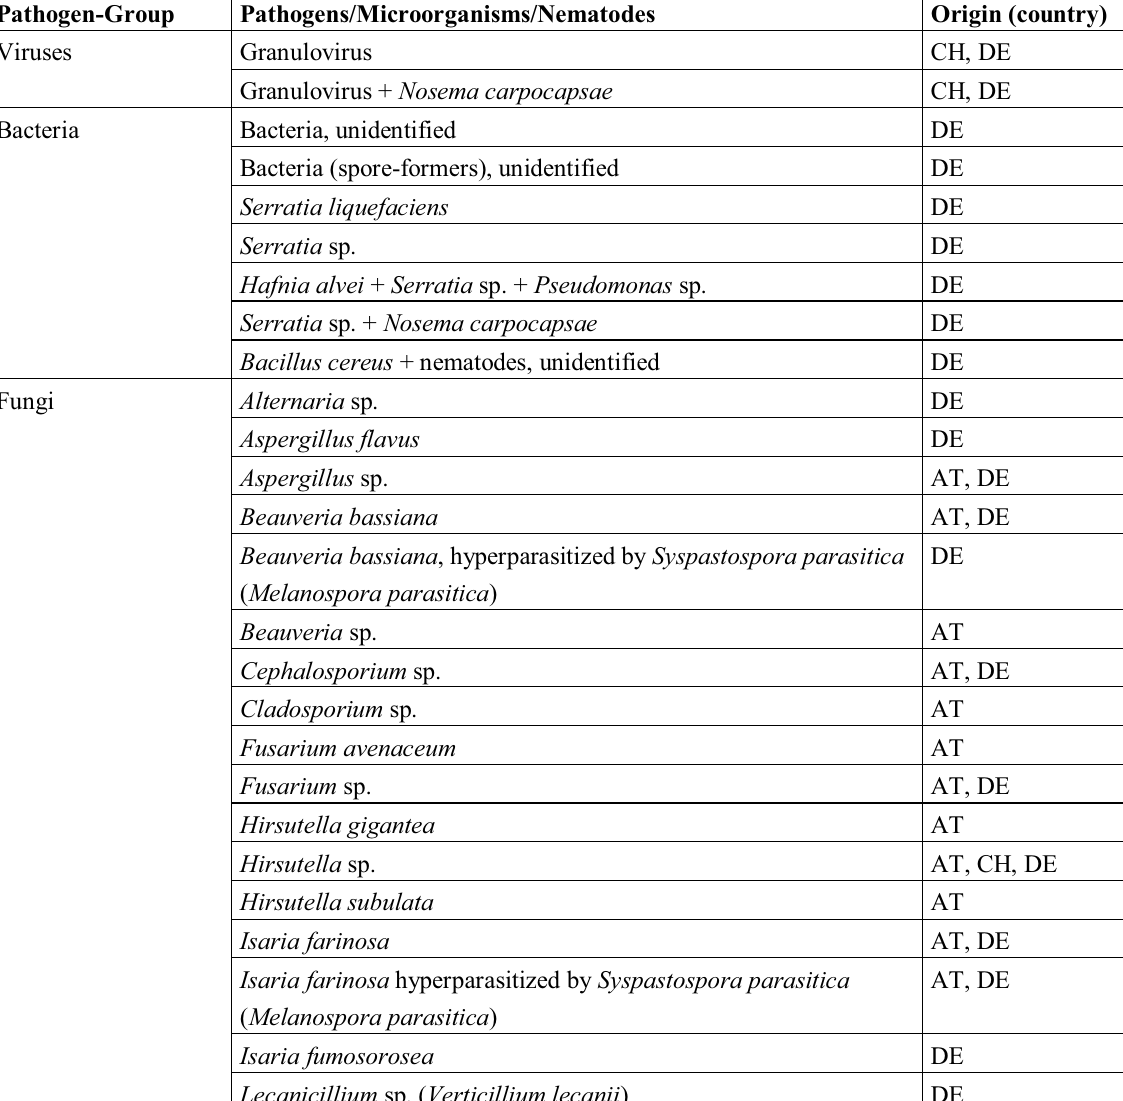
Table 1. Overview on diagnosed pathogens, other microorganisms and nematodes in C. pomonella (larvae, pupae, adults) detected in the Institute for Biological Control (1955 (cid:177) 2012); (modified from [37]; AT, Austria; CH, Switzerland; DE, Germany).